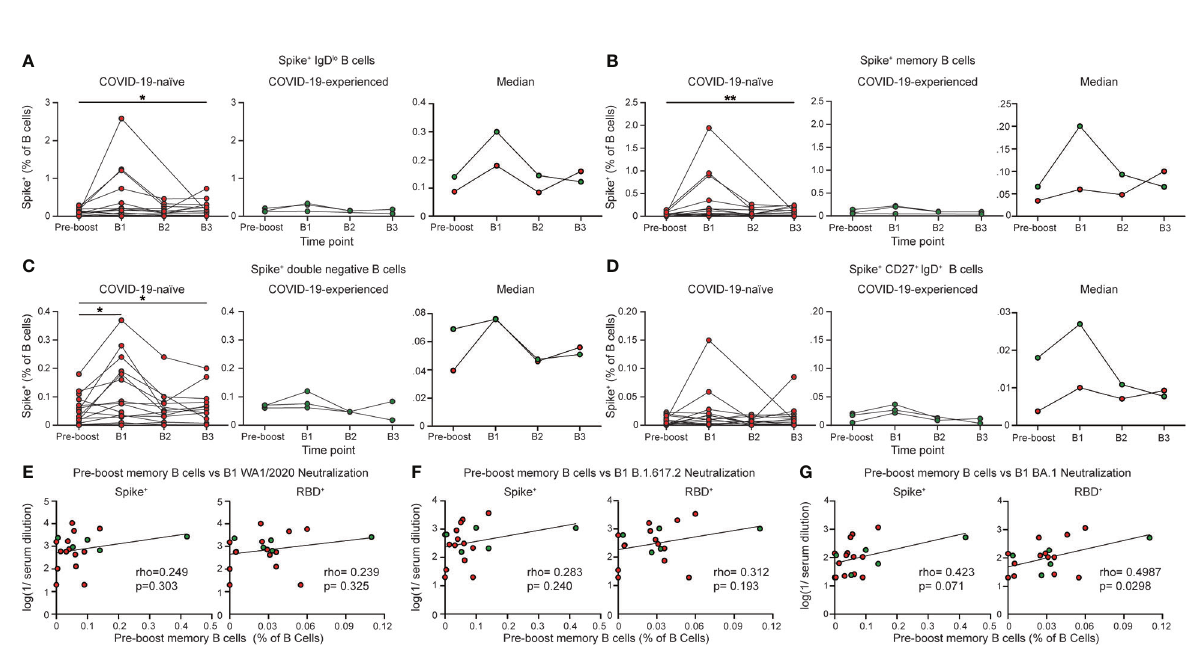
FIGURE 2 COVID-19-naïve PAD patients display elevated spike-speci fi c B cell response following booster vaccination. Percentage of (A) IgD lo , (B) memory (IgD lo CD20 + CD38 int-lo CD27 + ), (C) double negative (IgD lo CD20 + CD38 int-lo CD27 - ), and (D) IgD + CD20 + CD38 int-lo CD27 + Spike + cells among the B (Live CD19 + CD3 - ) cell population in the COVID-19-naïve PAD (left, red) and COVID-19-experienced PAD (middle, green) cohorts. Median percentage of B cells that comprise each population in all groups is shown on right. Correlation between percentage of B cells that are Spike + (left) or RBD + (right) memory cells prior to boosting and the serum neutralizing activity against (E) WA1/2020, (F) B.1.617.2, and (G) BA.1. The pre-boost group consists of the last sample obtained from each patient prior to booster vaccination. Statistical analyses were performed using a mixed effects model (for trends found between time points) with Fisher ’ s least signi fi cant difference testing in (A – D) , or a Pearson rank correlation (with Pearson trend lines for visualization) in (E – G) . (* p < 0.05; ** p < 0.01). Signi fi cance testing between time points was limited to comparisons relative to pre-boost. See also Figure